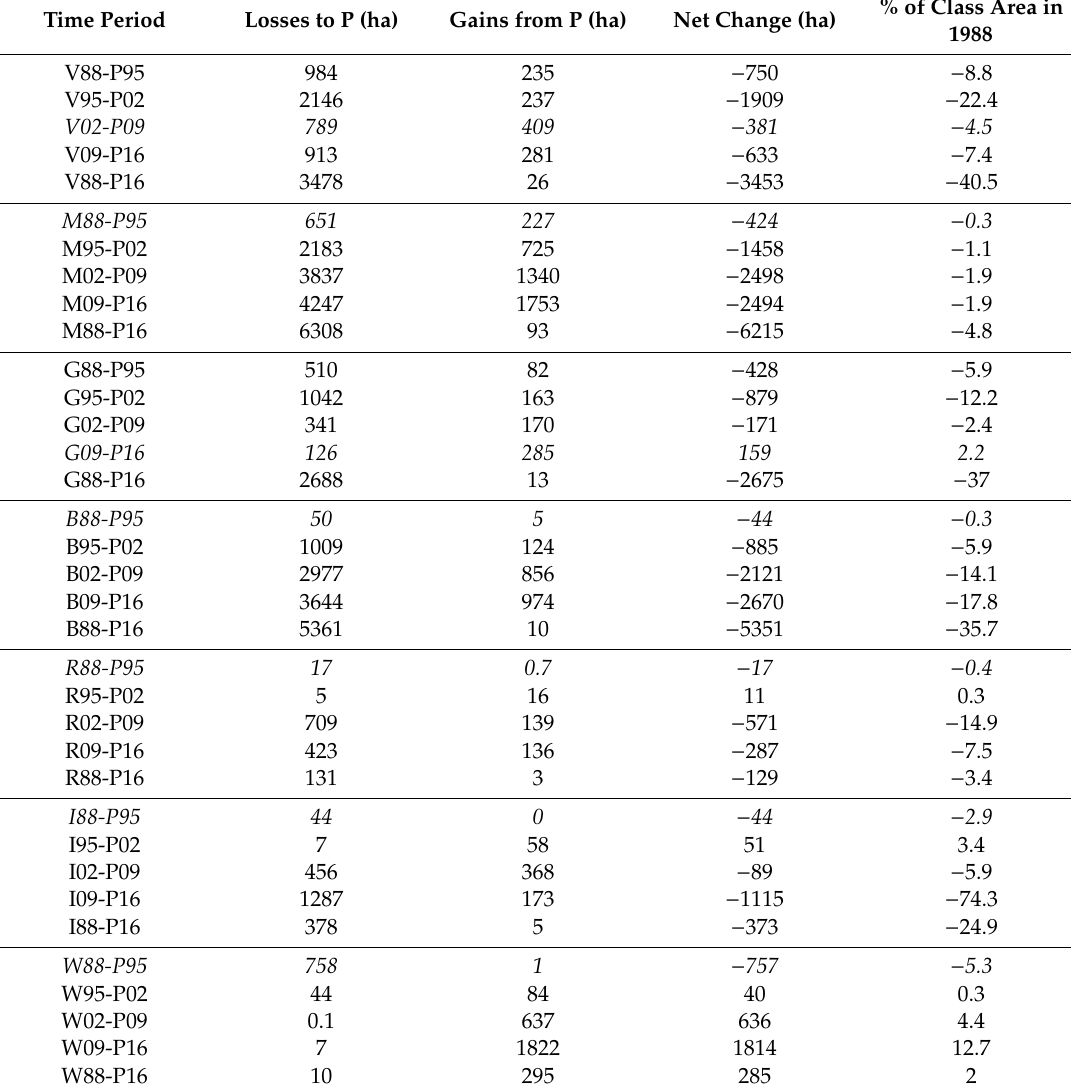
Table 5. The net impact of Prosopis invasion on individual LULC for 1988–1995, 1995–2002, 2002–2009, 2009–2016, and for 1988–2016. The numbers represent the time interval, V ( Vachellia tortilis ), P ( Prosopis ), M (Mixed vegetation), G (Grassland), B (Bareland), R (Rainfed cropland), I (Irrigated cropland), W (Water). Rows in bold represent periods with highest change, rows in italics periods with lowest change. The rows with border line represent the overall net changes associated with Prosopis invasion from 1988 to